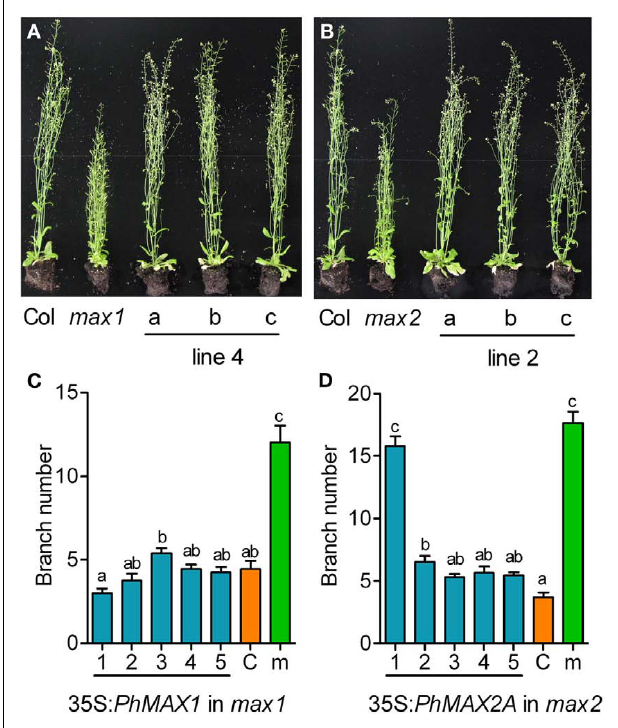
FIGURE 7 | Complementation of max mutants by petunia genes. (A) Representative late flowering stage (8-week-old) Arabidopsis plants are shown for the genotypes: “Columbia” (Col) wild-type, max1 mutant, and the fourth of theT3 transgenic max1 /35S: PhMAX1 lines (a–c). (B) Col, max2 , and the second of theT3 max2 /35S: PhMAX2A lines (a–c). (C,D) Graphs showing the mean branch number ( ± SEM, n ≥ 6) of transgenic, wild–type, and mutant Arabidopsis .Values with the same lowercase identifier are not significantly different ( P = 0.05). (C) Five independentT3 lines of max1 /35S: PhMAX1 compared with Col, C, and max1 , m, plants. (D) Five independentT3 lines of max2 /35S: PhMAX2A compared with Col, C, and max2 , m,